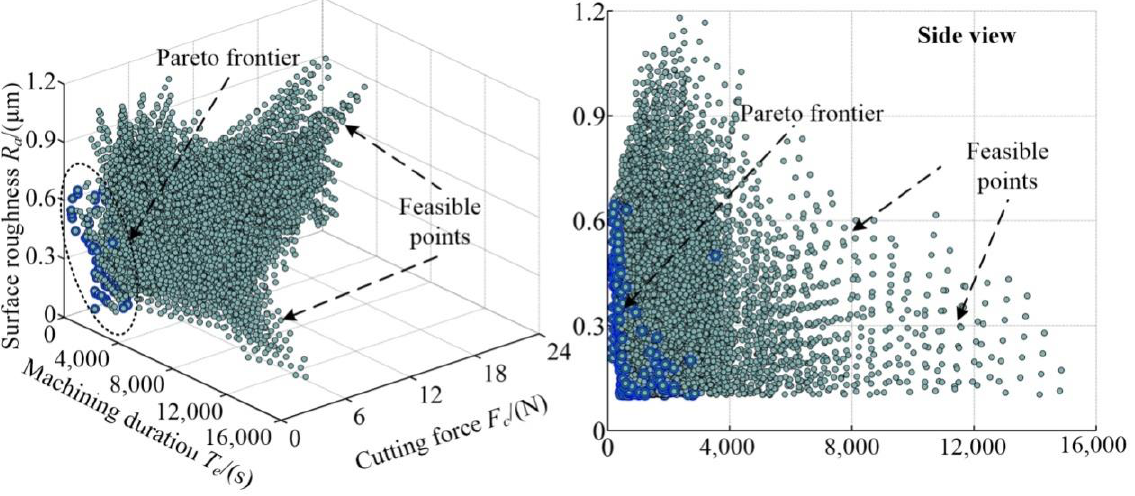
Figure 7. Feasible solutions and their Pareto frontier.